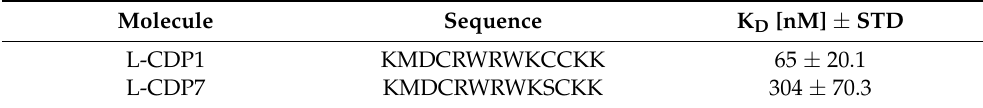
Table 2. SARS-CoV-2 3CL pro SPR experiments by L-CDP1 and L-CDP7.